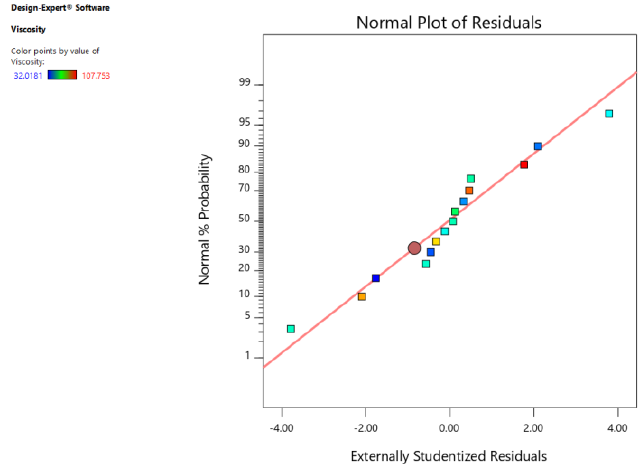
Figure A2. The normal probability plot of residuals versus predicted response values.